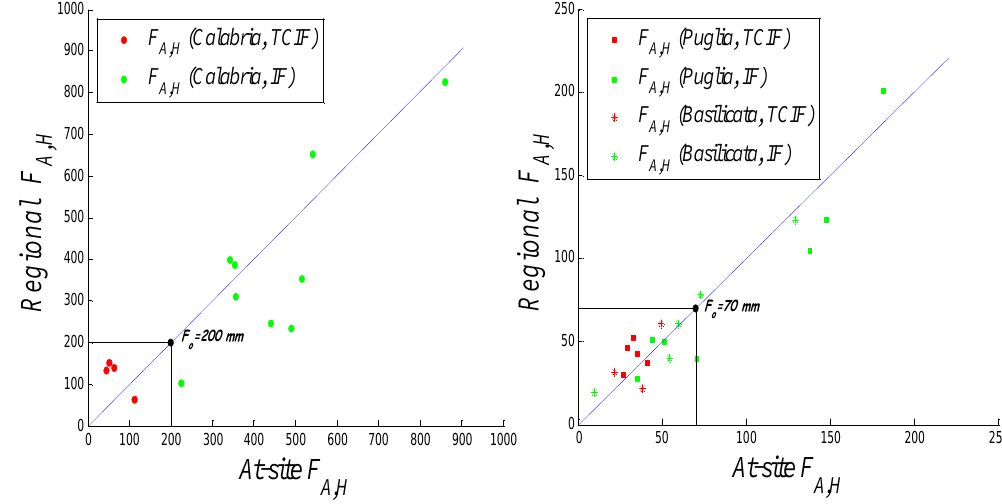
Fig. 8. Comparison between the at-site and regional estimates of F A,H for all river